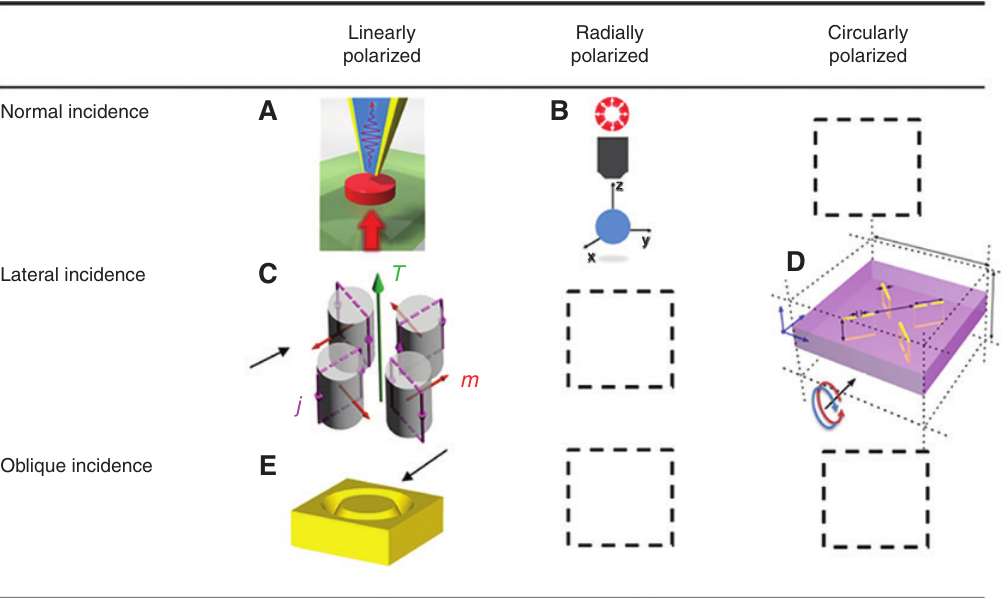
Figure 6: Different excitation strategies for toroidal moments in metamaterials via polarization and incidence directions. Dashed boxes denote no published result yet. Figure reproduced from (A) Ref. [111], Creative Commons CC-BY license; (B) Ref. [130], OSA; (C) Ref. [112], APS; (D) Ref. [101], APS; (E) Ref. [116],